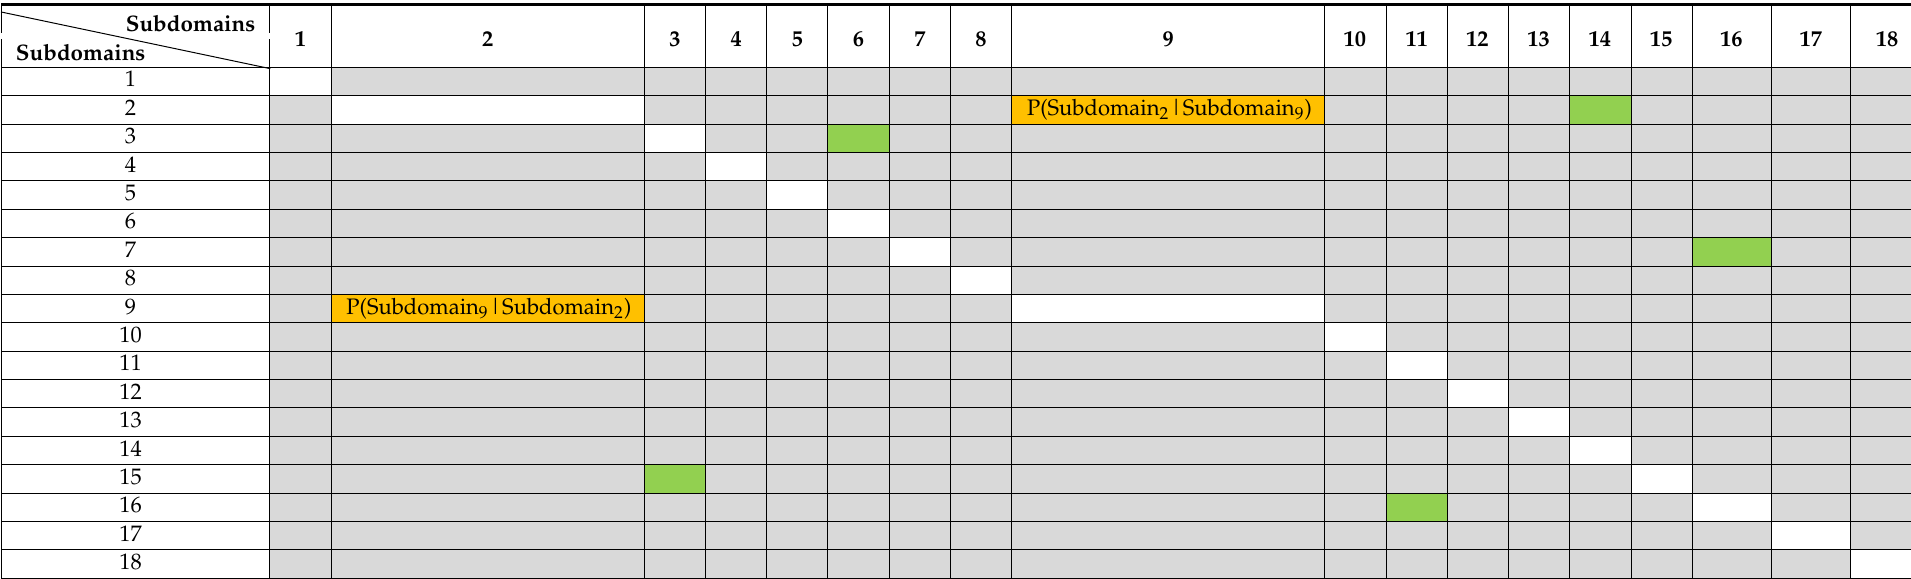
Table 8. Conditional Probabilities Table (CPT) (The background color to show the diameter of the matrix which is highlighted in white